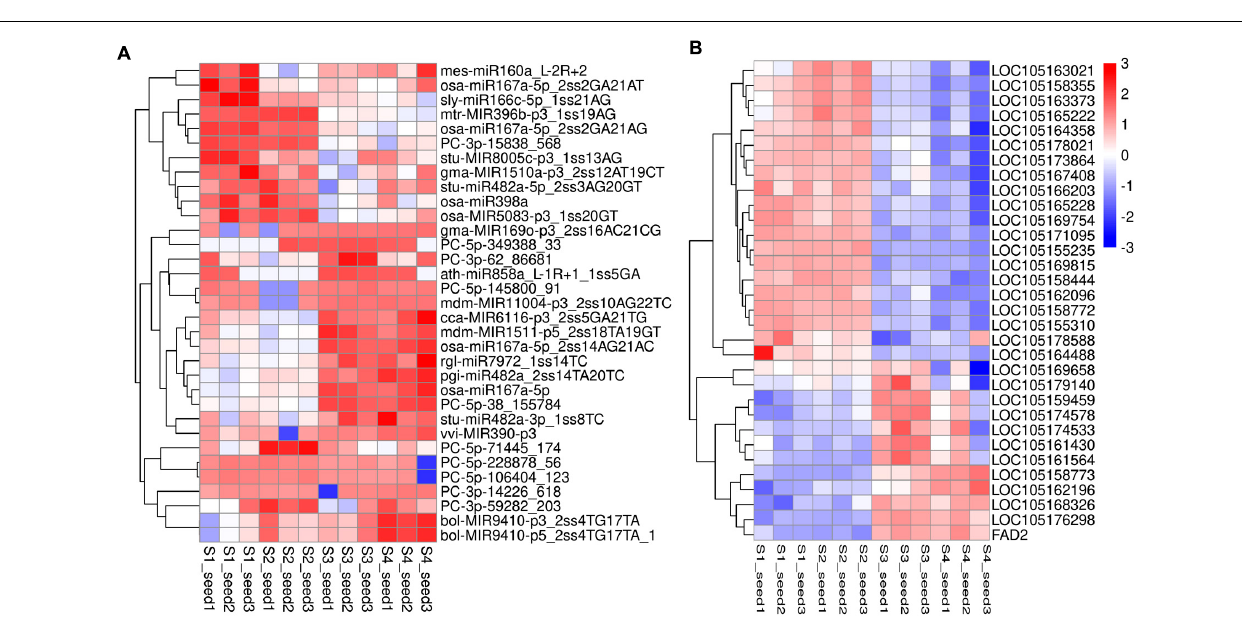
FIGURE 6 | Heat map of DEmiRNAs (A) and their target genes (B) indicating the expression pattern in different seed development periods of sesame. The corresponding color changes from blue to red with signal intensity ranges from –3.0 to +3.0. The miRNAs expression values were standardized by Z -score